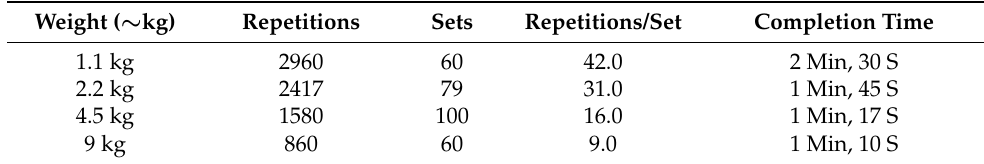
Table 2. The nominated dumbbells weights for the data collection process, the values reported are